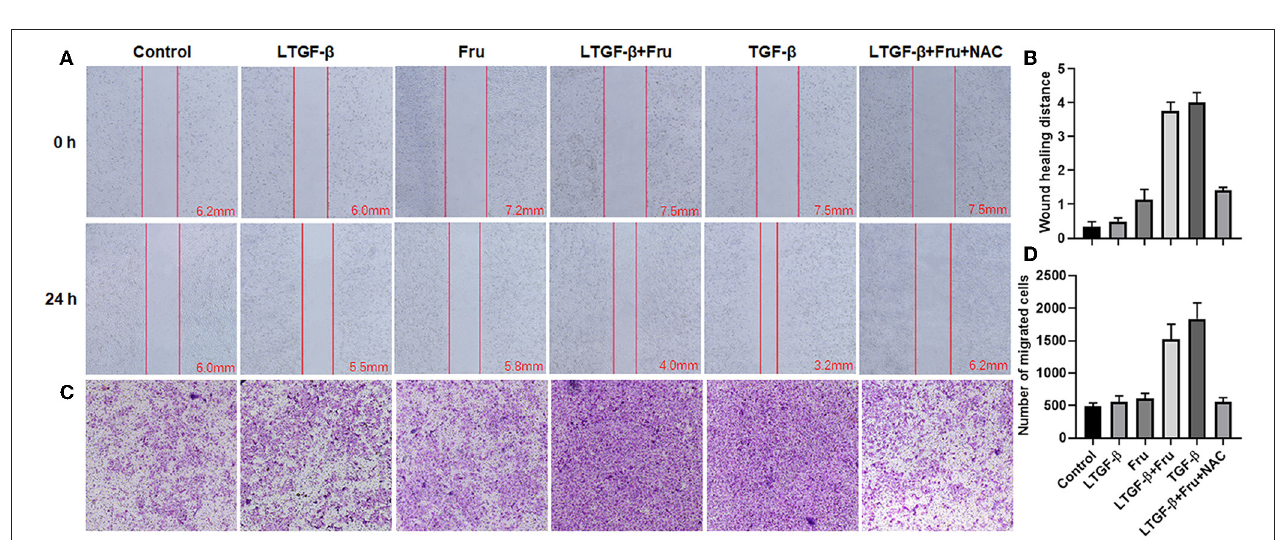
FIGURE 9 | Effect of fructose on the P-Smad3 and Snail expression and latent TGF- β 1 converted to TGF- β 1 in latent TGF- β 1-induced A549 cells. A549 cells were treated under the indicated condition for 24h, and then western blot analyzed the P-Smad3 and Snail protein levels (A–J) , and ELISA measured the leftover latent TGF- β 1 level (K) . Data are set as the Mean ± S.E.M ( n = 3). Comparisons between groups were achieved using a one-way ANOVA followed by Tukey’s test. * p < 0.05, ** p < 0.01, ** p < 0.001 vs. the control group; # p < 0.05, ## p < 0.01, compared with the LTGF- β 1 + 10mM Fructose group. LTGF- β 1, latent TGF- β 1; NAC, N-Acetyl-l-cysteine.